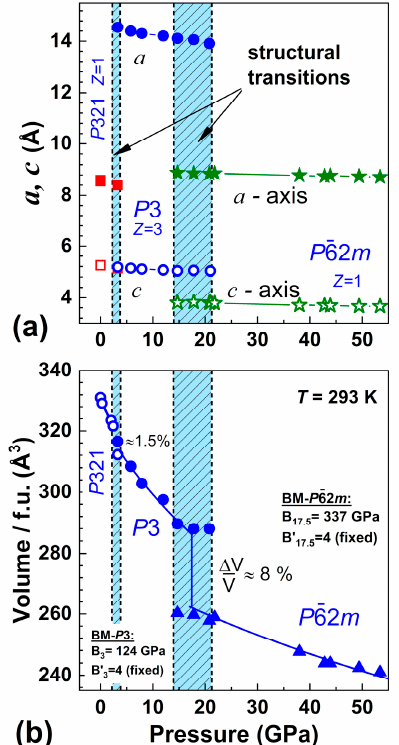
Figure 3. (Colour on-line) Pressure dependences of the unit cell parameters a , c ( a ) and the values of volume V for formula unit ( b ) in BNFS at room temperature. The shaded regions indicate the pressure interval of the coexistence of the structural phases. Symbols correspond to phases P 321, P 3, P 62 m .